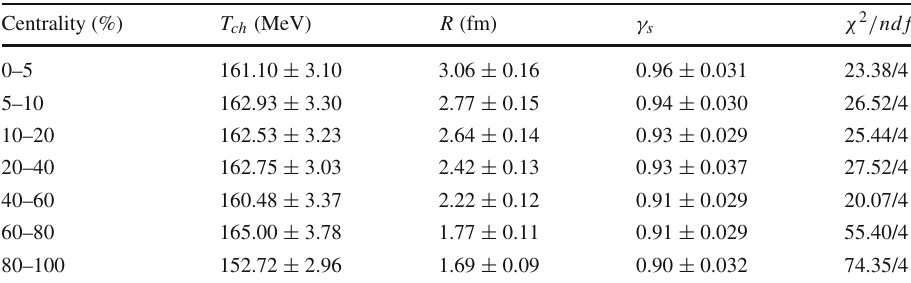
Table 1 Chemical freeze-out temperature ( T ch ), radius (R), γ s and χ 2 / ndf of the fits for various multiplicity